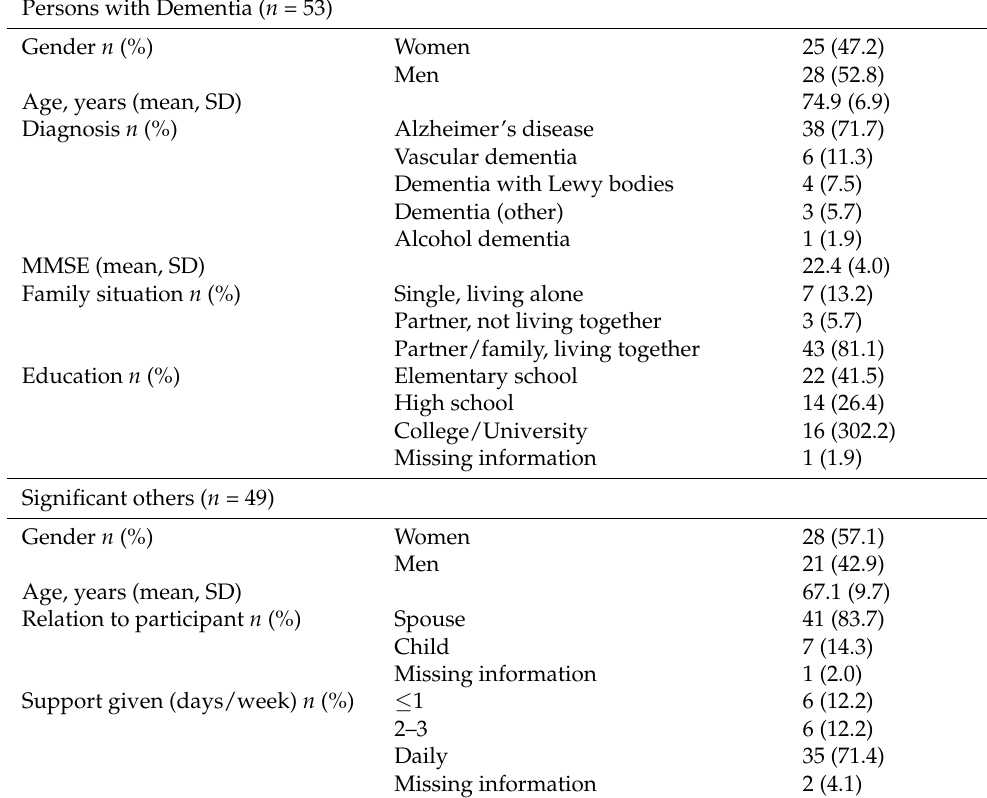
Table 1. Basic characteristics of participants with dementia and their significant